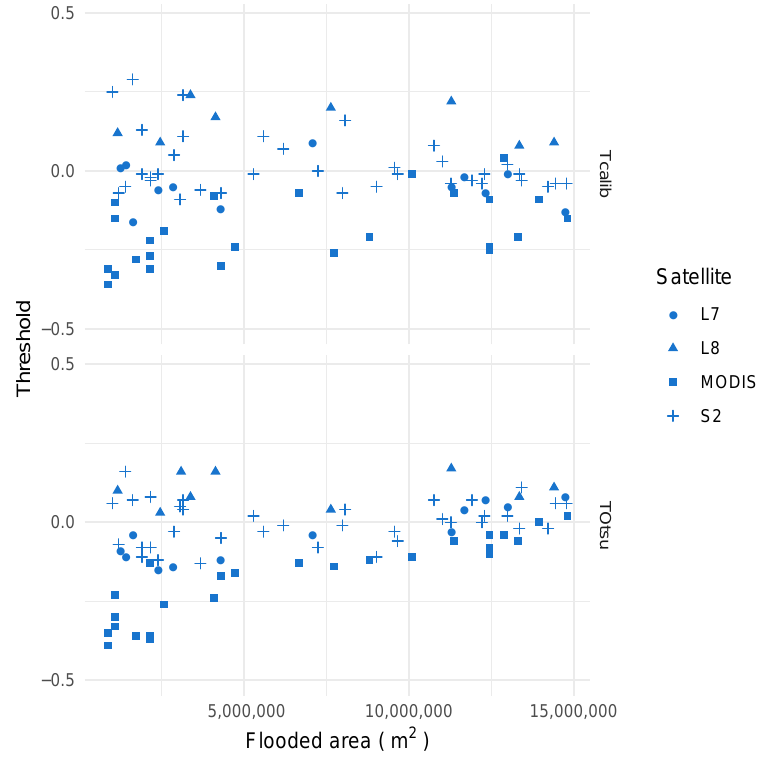
Figure 5. Comparison of optimal threshold based on the Otsu algorithm (TOtsu) and on calibration against field data (Tcalib) for Landsat 7, Landsat 8, MODIS and Sentinel-2 as a function of the flooded